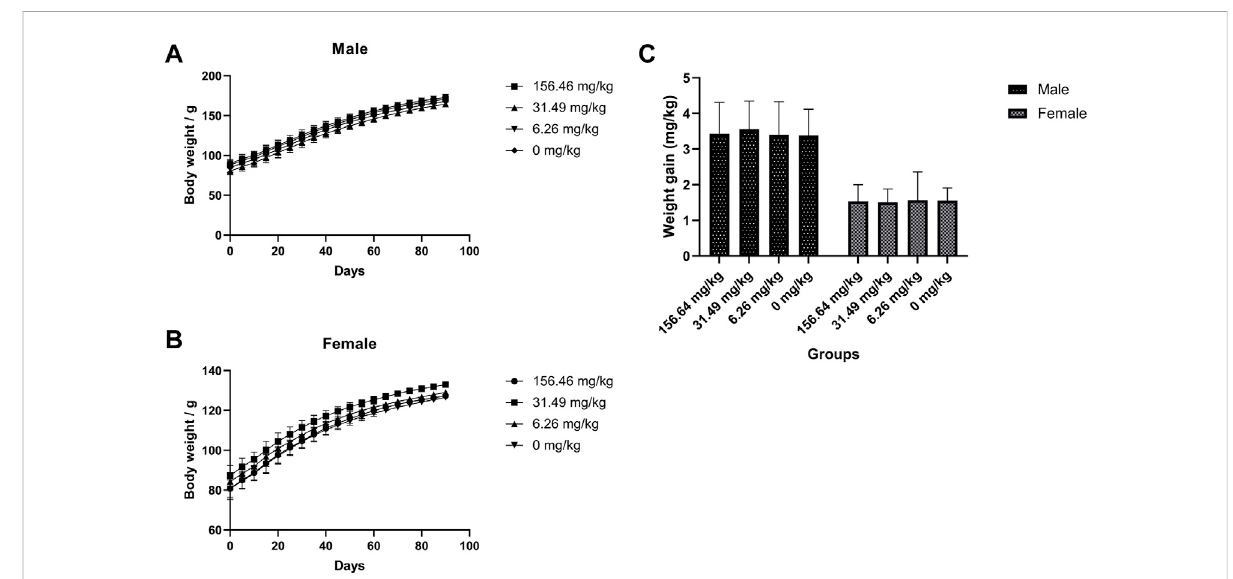
FIGURE 2 No effect of MCE on body weight gain in SD rats during 90 days of feeding. Male and female rats were orally administered 156.46, 31.49, 6.26, and0 mg/kg( n =10rats/gender). (A) Bodyweightofmaleratsat90 days; (B) Bodyweightoffemaleratsat90 days; (C) Bodyweightgainofmaleand female rats for 90